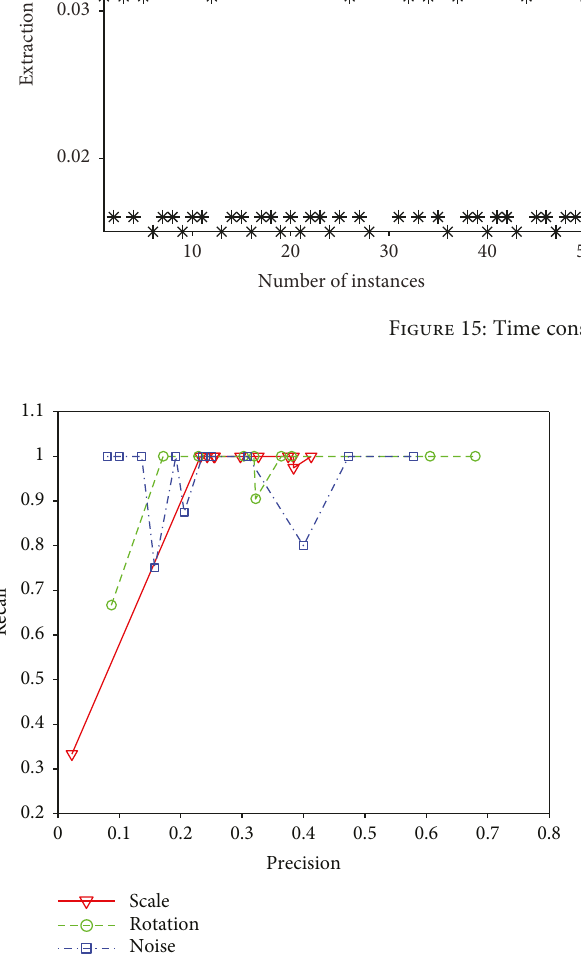
Figure 16: Recall versus precision graph of three methods under di ff erent conditions.